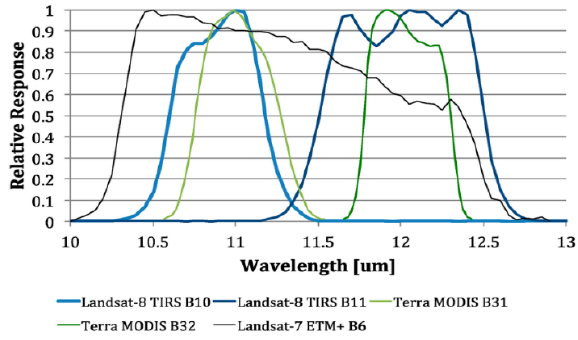
Figure 2. TIRS, MODIS and ETM+ relative spectral response functions (the data can be seen in[10])